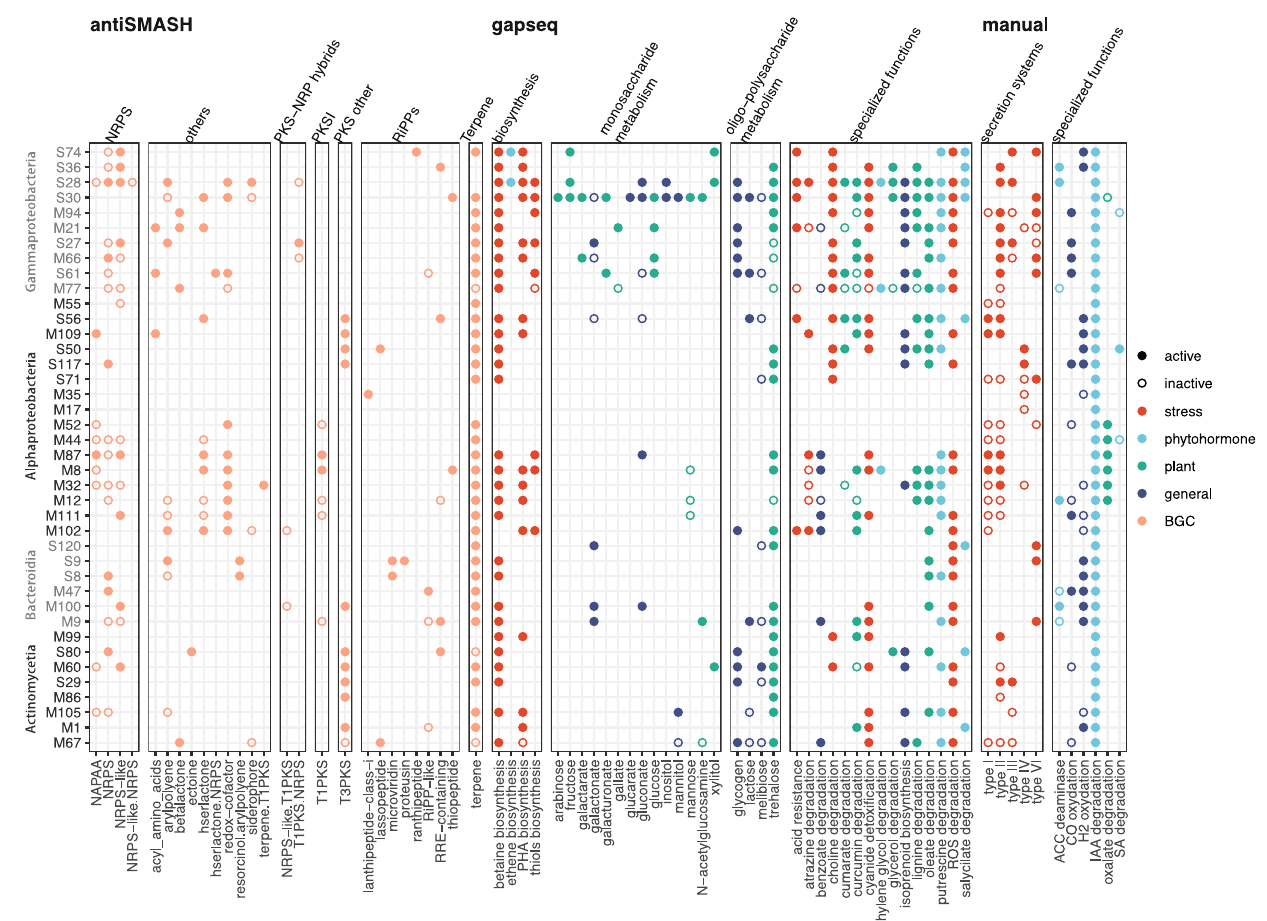
Fig. 6 | Key functional gene pathways detected in the 40 focal MAGs and their activities (mapped transcripts) during the 2016 – 2017 switchgrass growing season. Functionalgene pathways werecurated using antiSMASHfor biosynthetic gene clusters, gapseq for general metabolic pathways, and manual selection for plant-associative functions reported in the literature. Pathways that were